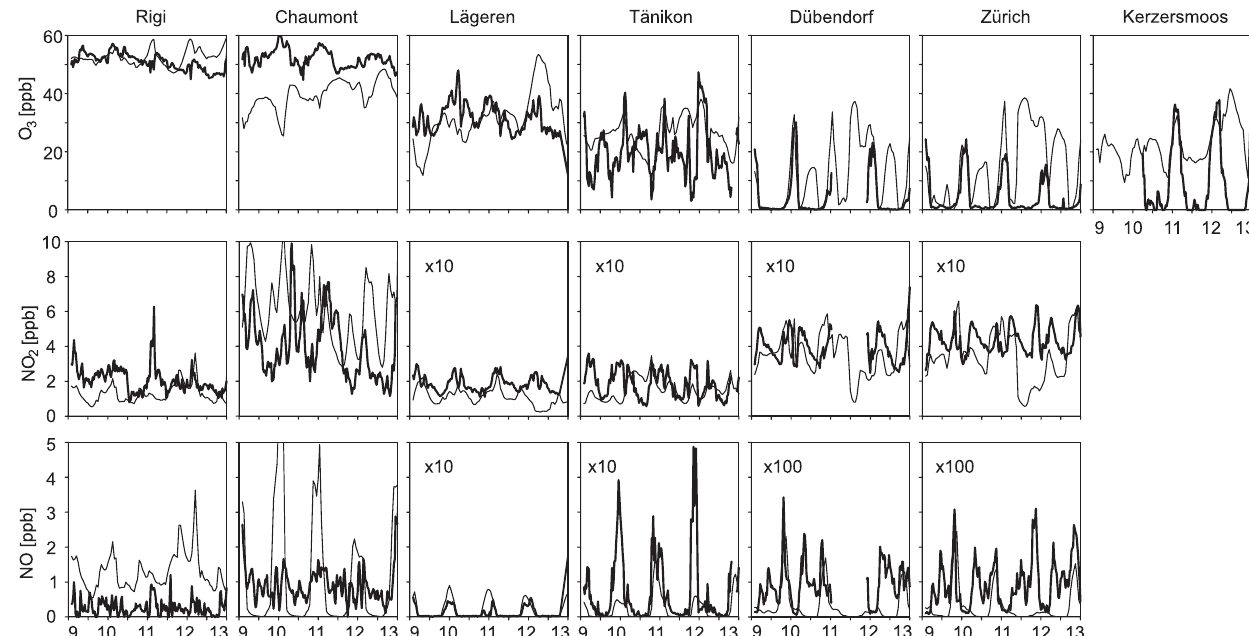
Fig. 7. Observed (thick lines) and modelled (thin lines) time series of NO, NO 2 and ozone at eight sites from 9 February, 12 UTC to 13 February, 12 UTC. For L¨ageren, which is on a 45 m tower on a steep slope, the corresponding grid cell was too low, therefore, we used a point more to the east at correct